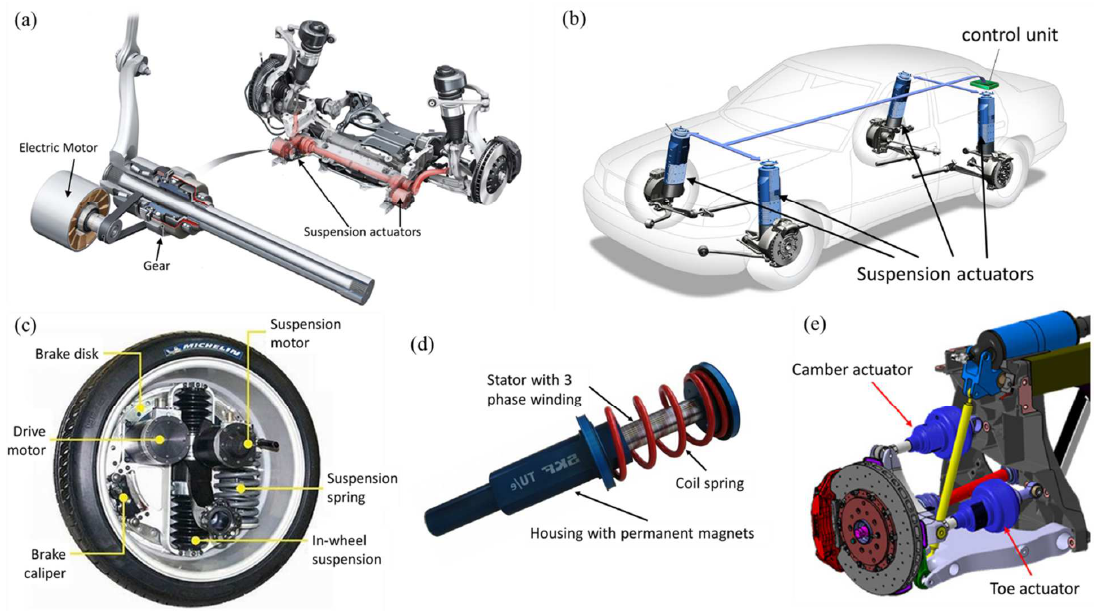
Figure 4. Examples of electromagnetic active suspension systems. ( a ) Audi active suspension system [22], ( b ) Bose active suspension [24], ( c ) Michelin active wheel [23], ( d ) EAS system of TU/e [25], ( e ) camber and toe actuators [26].